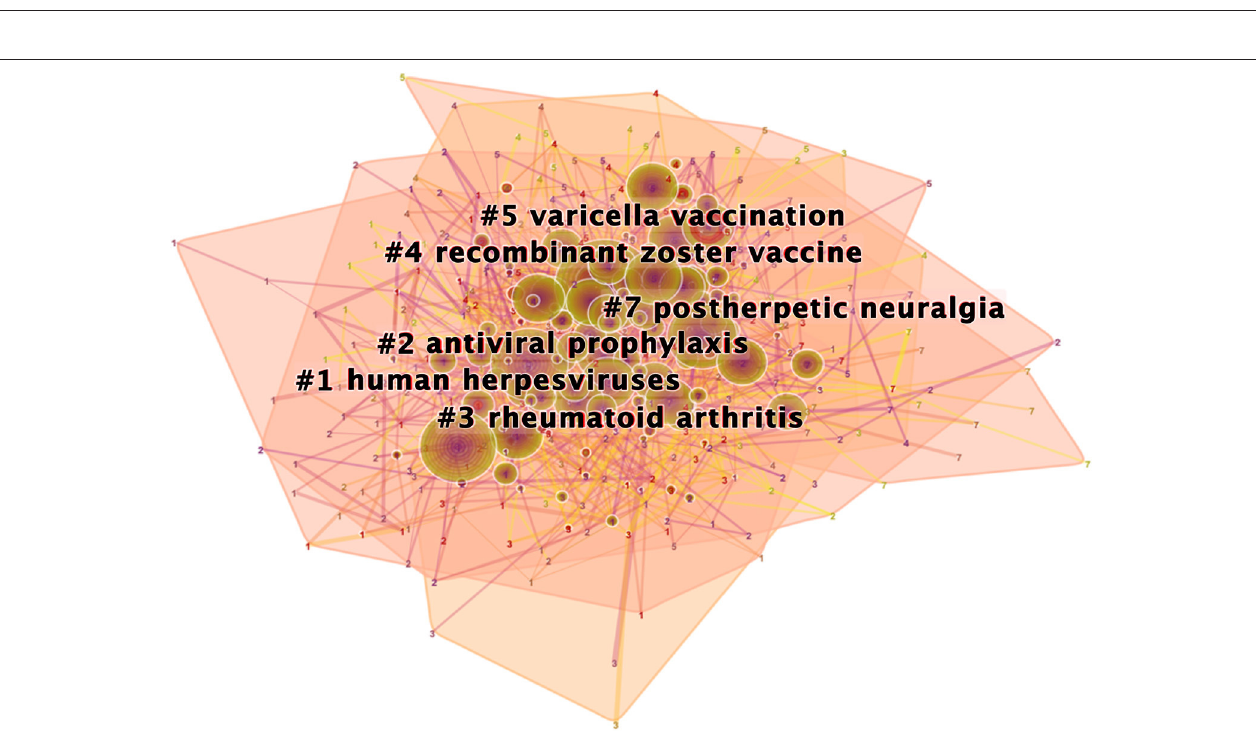
FIGURE 5 | The timeline view of co-cited references clusters with their cluster-labels on the right.